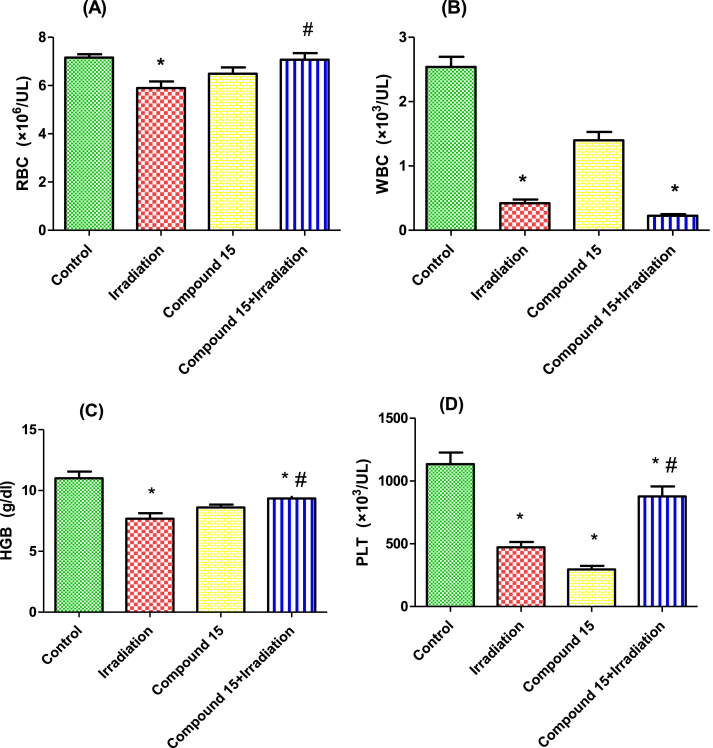
Effect of compound 15 on: (A) RBCs, (B) WBCs, (C) HGB concentration and (D) PLT counts in non-irradiated (control) and irradiated mice after 3 days of irradiation. The results were expressed as mean ± S.E. (n = 5). Statistical analysis was carried out by one-way ANOVA followed by Bonferroni’s multiple comparison test. ∗: significantly different from control group, #: significantly different from irradiated group.